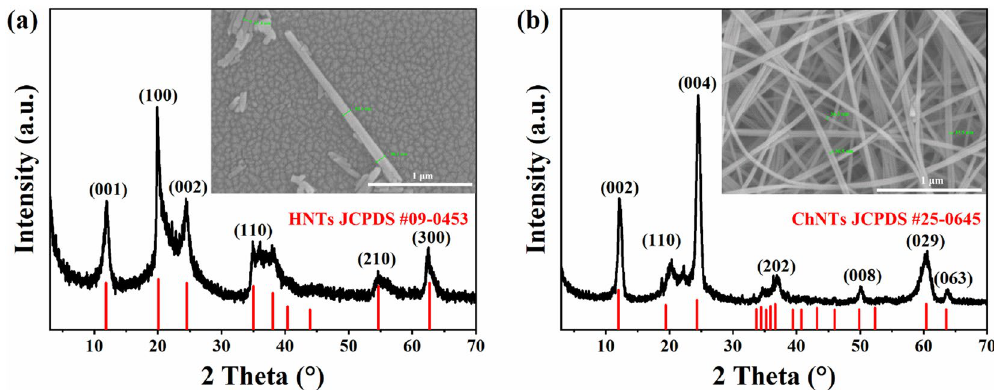
Figure 3. XRD pattern of natural mineral adsorbents: ( a ) HNTs; ( b ) ChNTs. Inset: SEM images of natural mineral adsorbents.